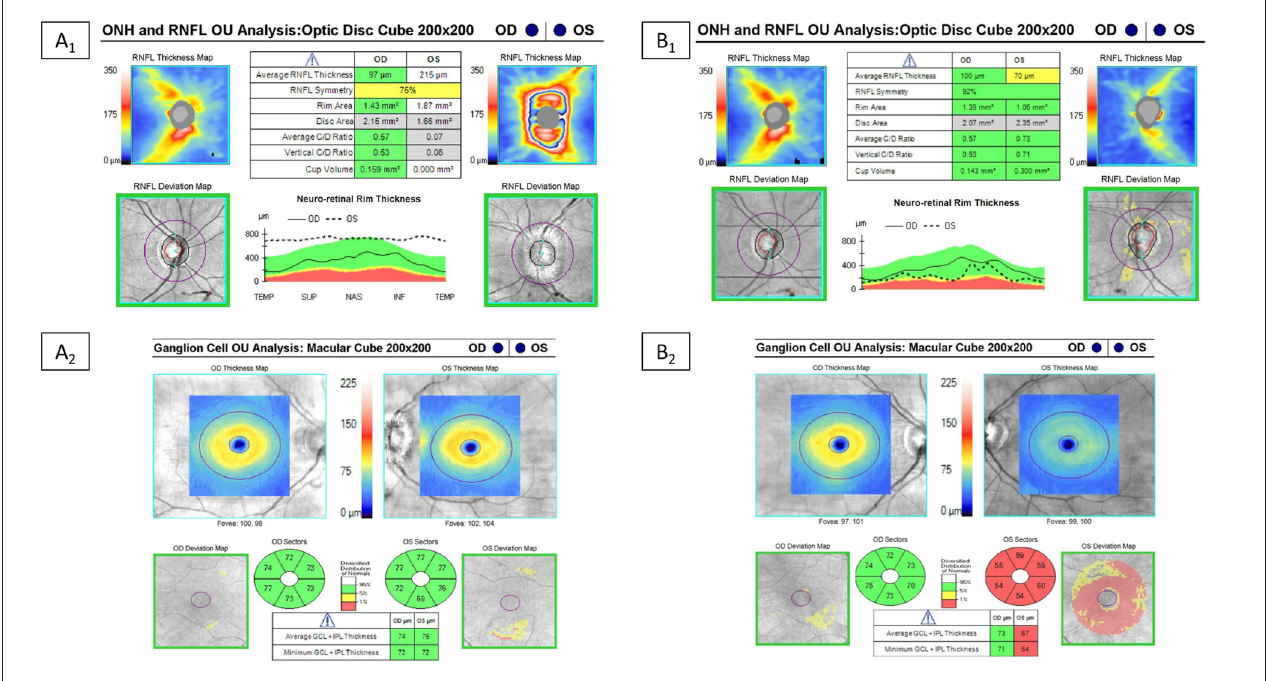
FIGURE 7 | Example of optical coherence tomography alterations in patients with MOGAD ON. Optical coherence tomography in a MOGAD patient with optic neuritis in the left eye. Left images (A1,A2) are the OCT images at the time of the acute optic neuritis, which shows significant peripapillary retinal nerve fiber layer thickening (RNFL) in the left eye and a normal ganglion cell-inner plexiform layer (GC-IPL) thickness. Images on the right (B1,B2) are the repeat OCT 1 year after the optic neuritis attack, which shows thinning of the peripapillary RNFL and macular GC-IPL in the left eye despite recovery back to a visual acuity of